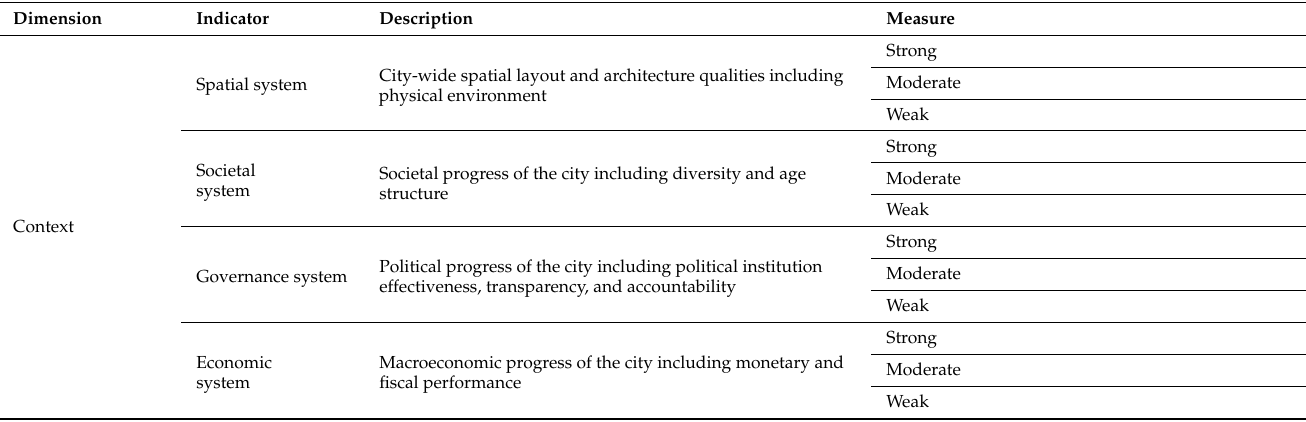
Table 1. Multidimensional innovation district performance